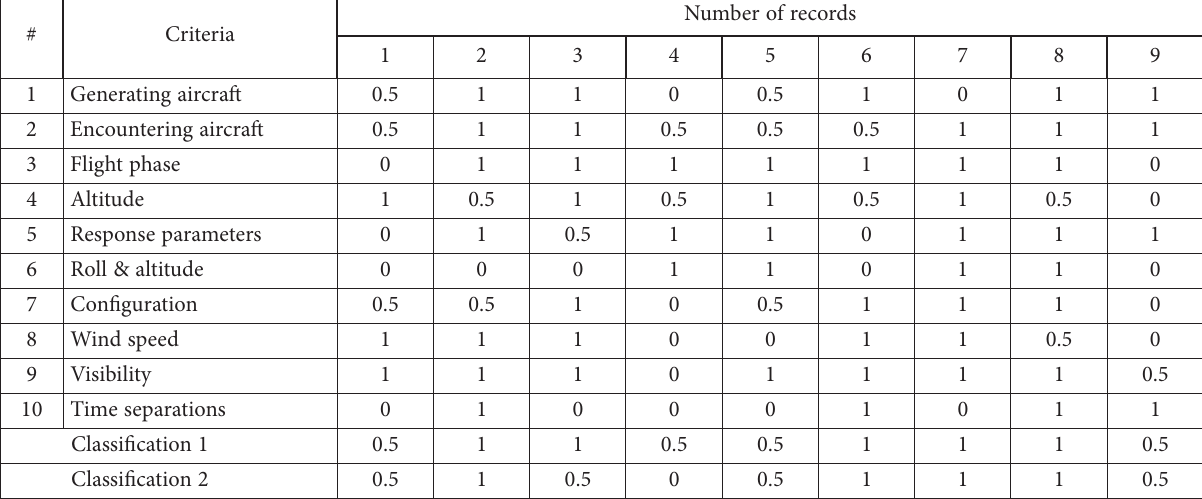
Table 3. Records classification based on criteria derived from pilot